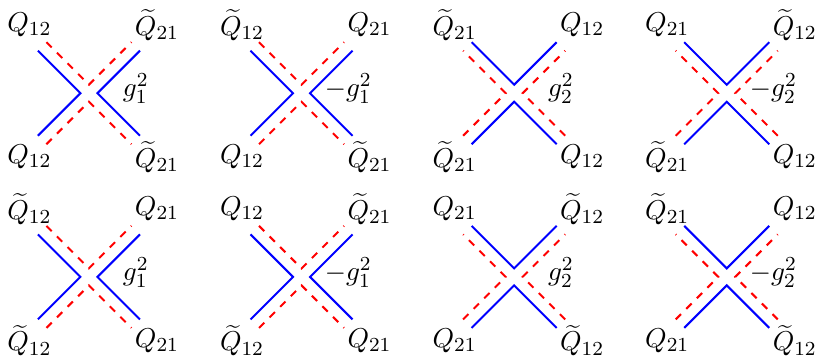
Figure 2 . The vertices contributing to the Hamiltonian in the XY sector. A solid blue line denotes the first and a dashed red line denotes the second gauge group. Time moves upwards. Here we have already performed the Wick contractions of the conjugate fields with the second gauge invariant operator to write the vertices directly as spin chain